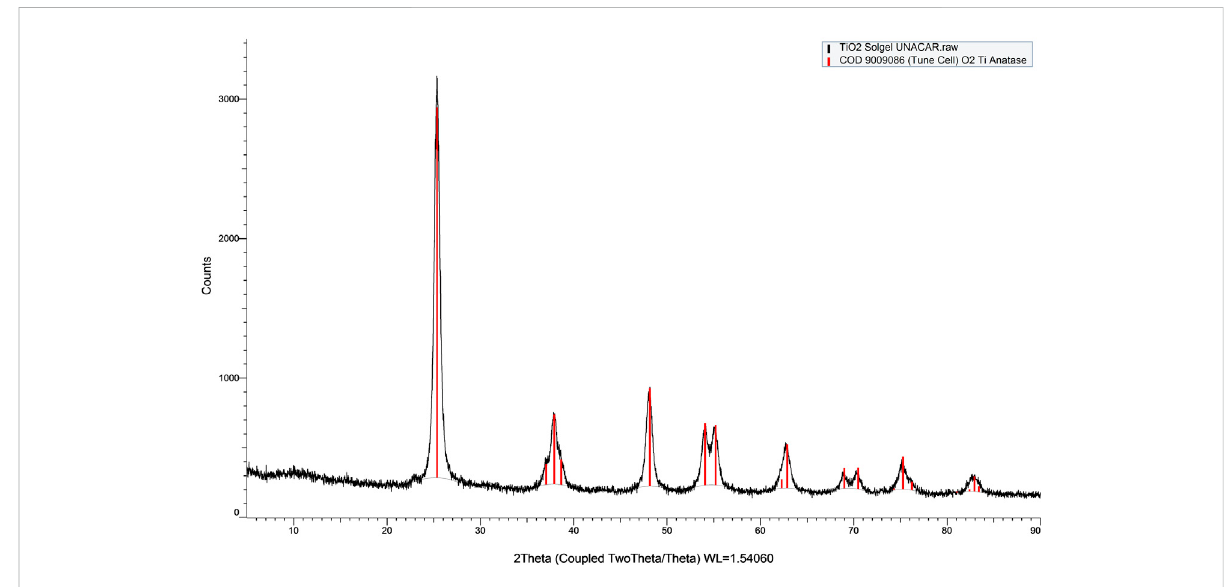
FIGURE 1 X-ray diffraction pattern (DRX) of the synthesized catalyst (TiO 2 -Ag).